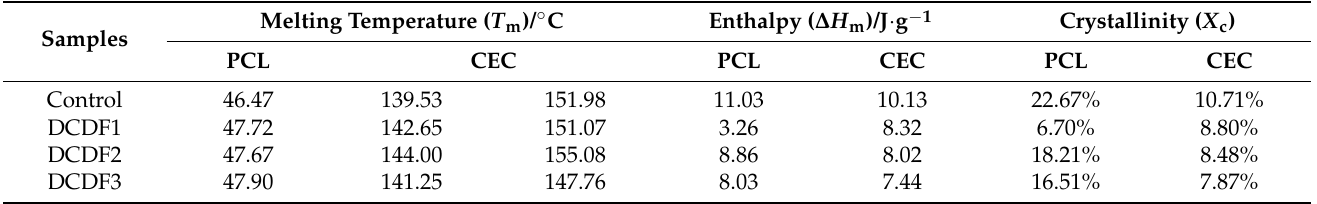
Table 2. The detailed thermal properties of DCDFs summarized from differential scanning calorimetry (DSC) results.